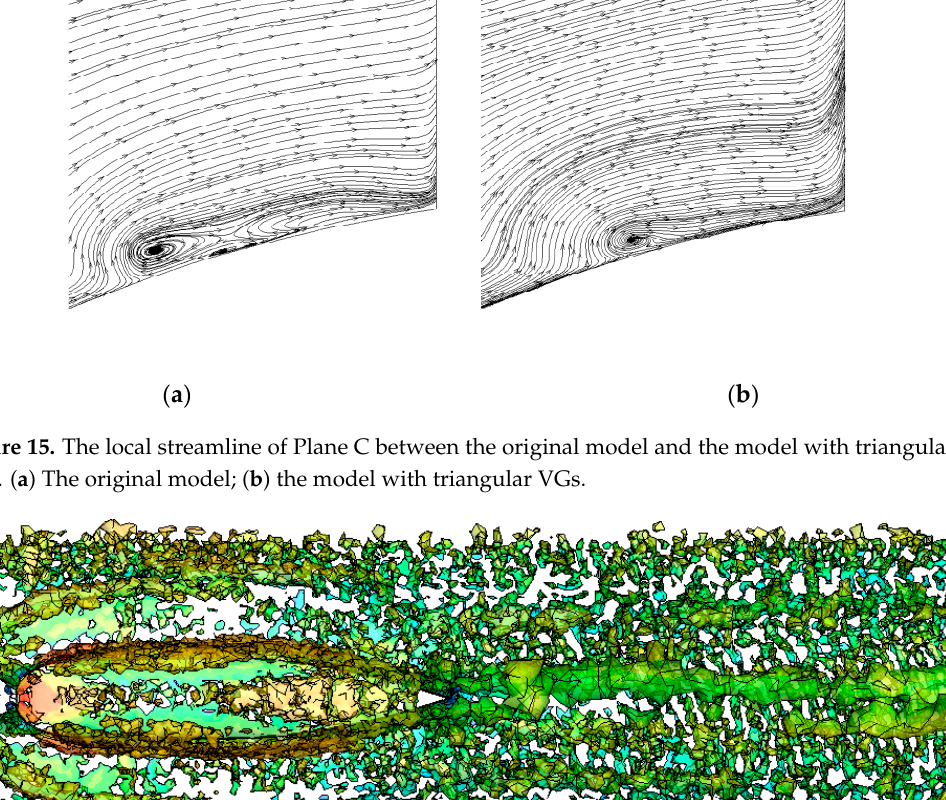
Figure 14. The streamline near the leading edge of Plane B between the original model and the model with triangular VGs. ( a ) The original model; ( b ) the model with triangular VGs.